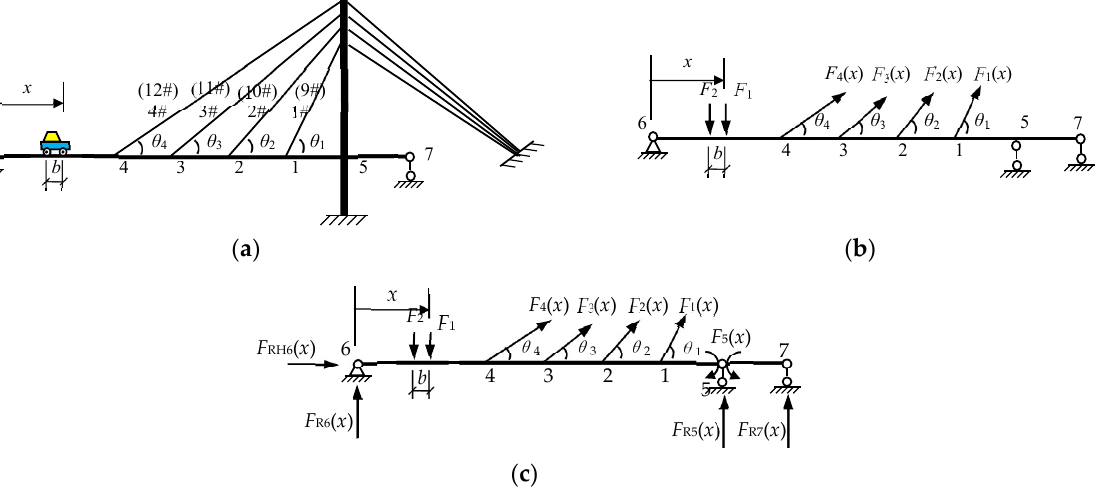
Figure 2. The cable force calculation diagram of the cable-stayed bridge. ( a ) A simple plane calculation diagram; ( b ) calculation diagram after the cables substituted by the cable forces; ( c ) the force method basic system.